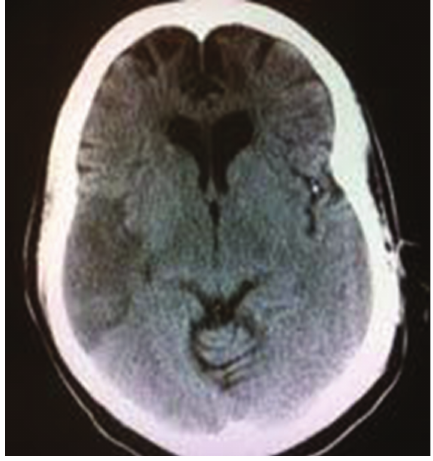
Figure 3: CT scan of the head without contrast showing a larger right MCA infarction compared Figure